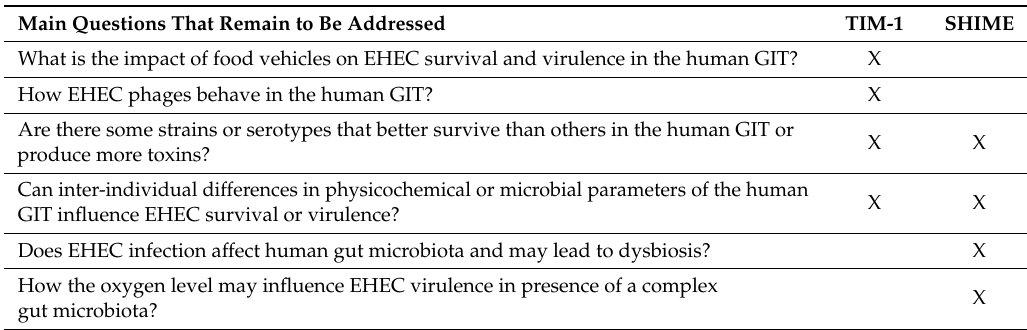
Table 2. Roles played by in vitro dynamic models to address important questions related to EHEC pathogenesis in the human gut.